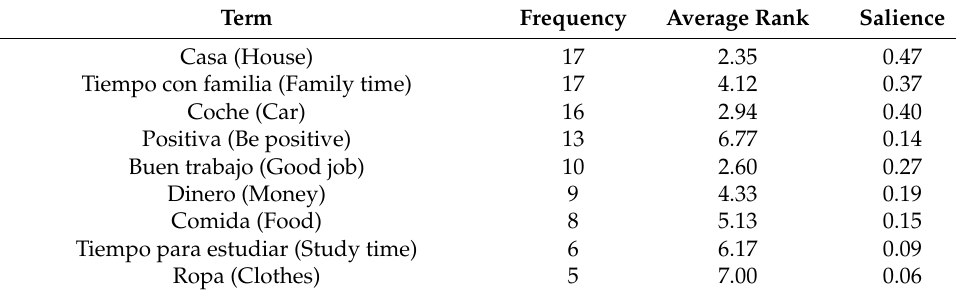
Table 2. Free-list terms for la buena vida